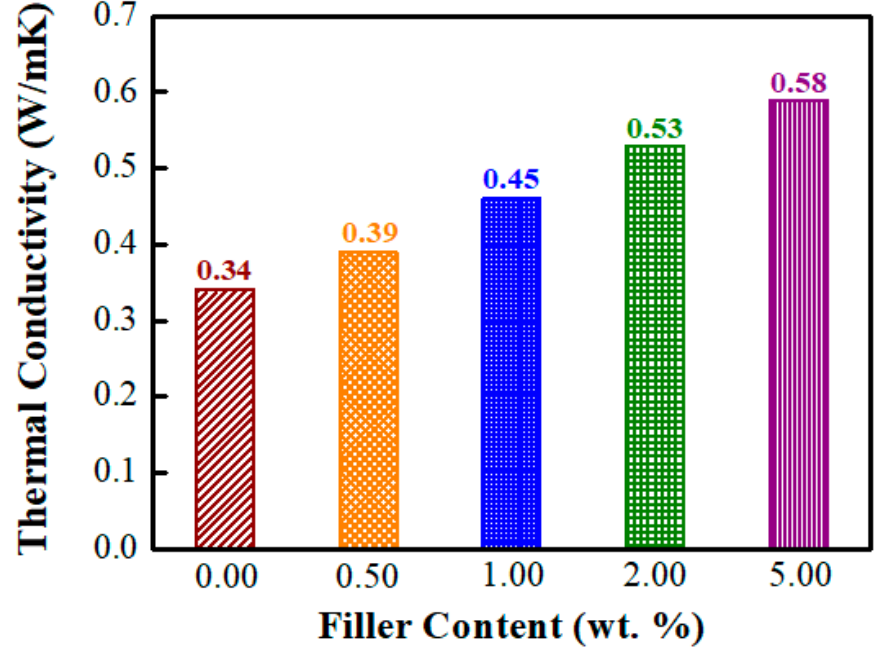
Figure 9. Thermal conductivity of neat K–LCE and its composites filled with di ff erent Si–BN contents.